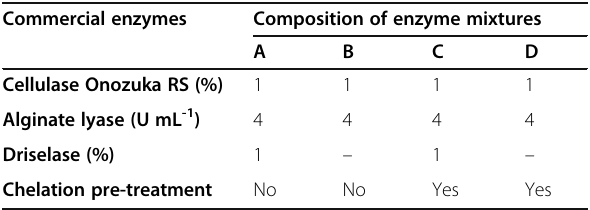
Table 1 Combinations and concentrations of enzyme mixtures for protoplast isolation from Dictyopteris pacifica and Scytosiphon